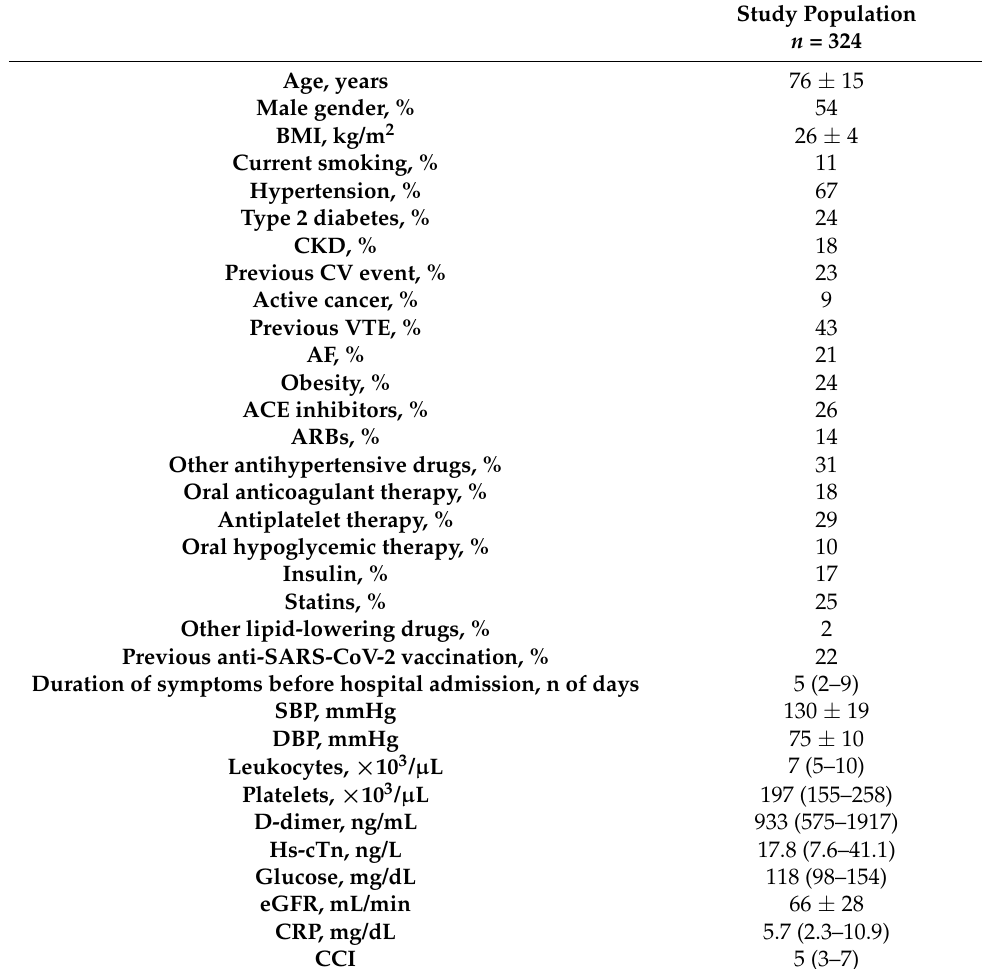
Table 1. Characteristics of the study